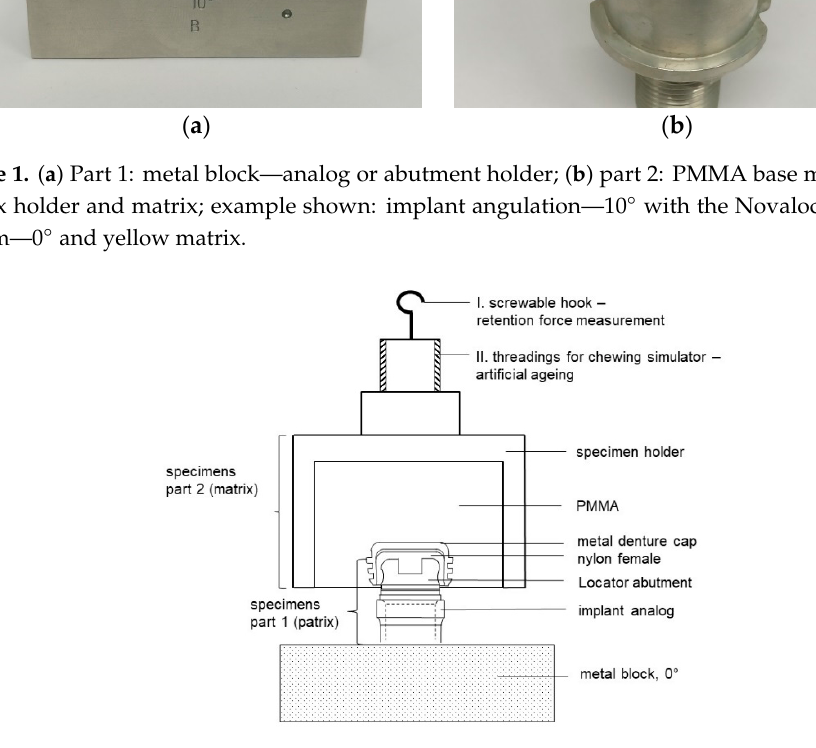
Figure 2. Schematic drawing: specimen attachment to the universal testing machine (I) and to the chewing simulator (II); example shown: implant angulation—0° with the Locator attachment system—0° and pink matrix.